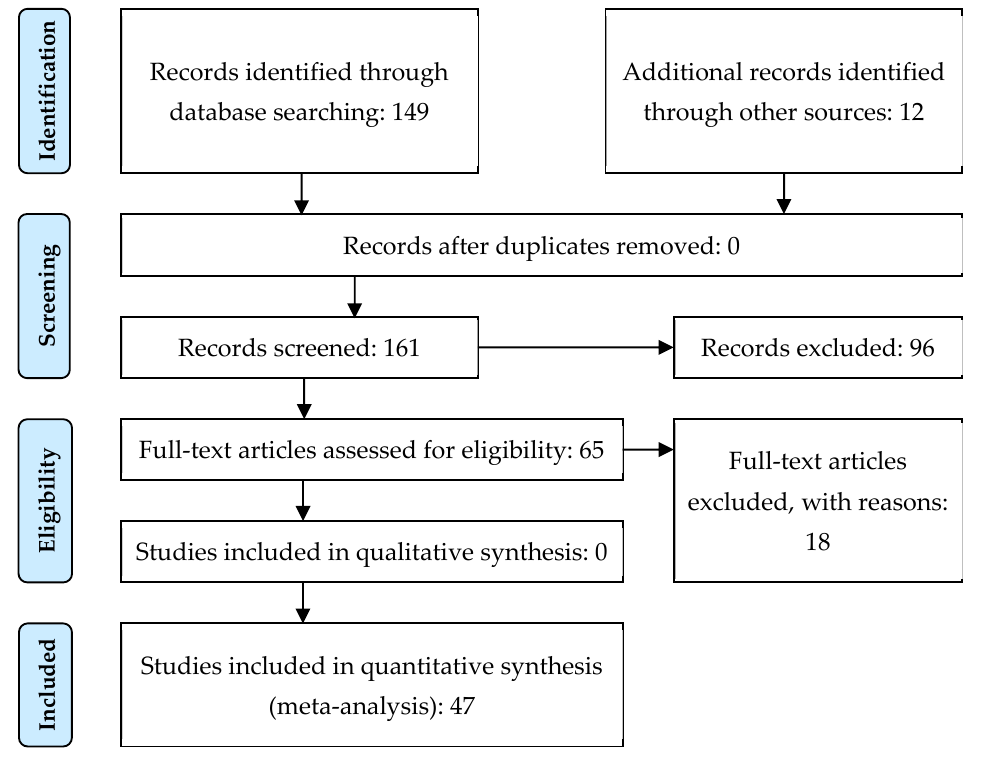
Figure 1. PRISMA methodology flowchart. Table 2. Literature results obtained with PRISMA tool.